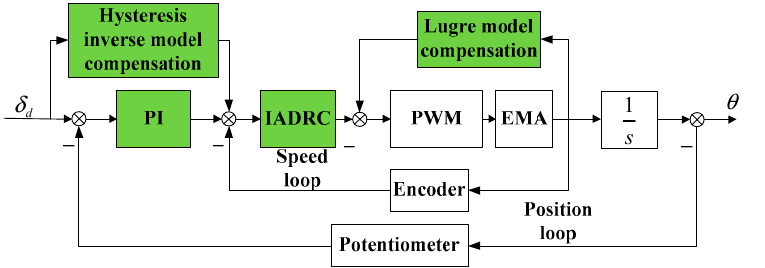
Figure 7. Control block diagram of the system.